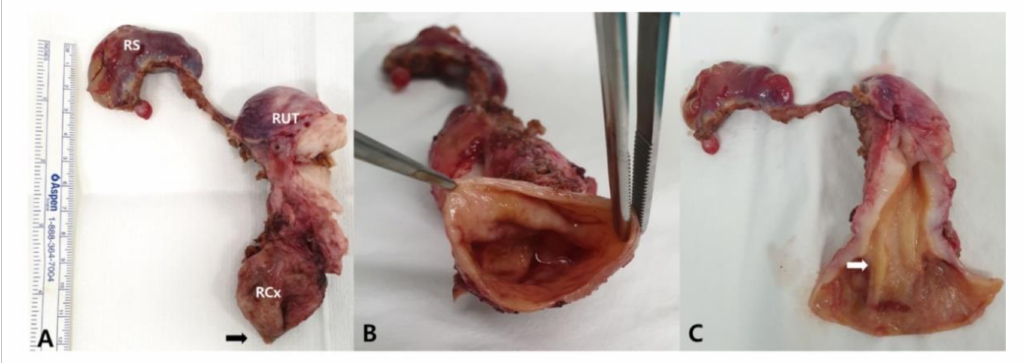
Figure 2. The retrieved uterus and biopsies were performed at two sites (arrows). The biopsied tissues were histopathologically confirmed as the exocervix (( A ), arrow) and endocervix (( C ), arrow), respectively. ( B ), Open the hematocervix revealed the dilated cavity. RS, right salpinx; RUT, right hemiuterus; RCx, right